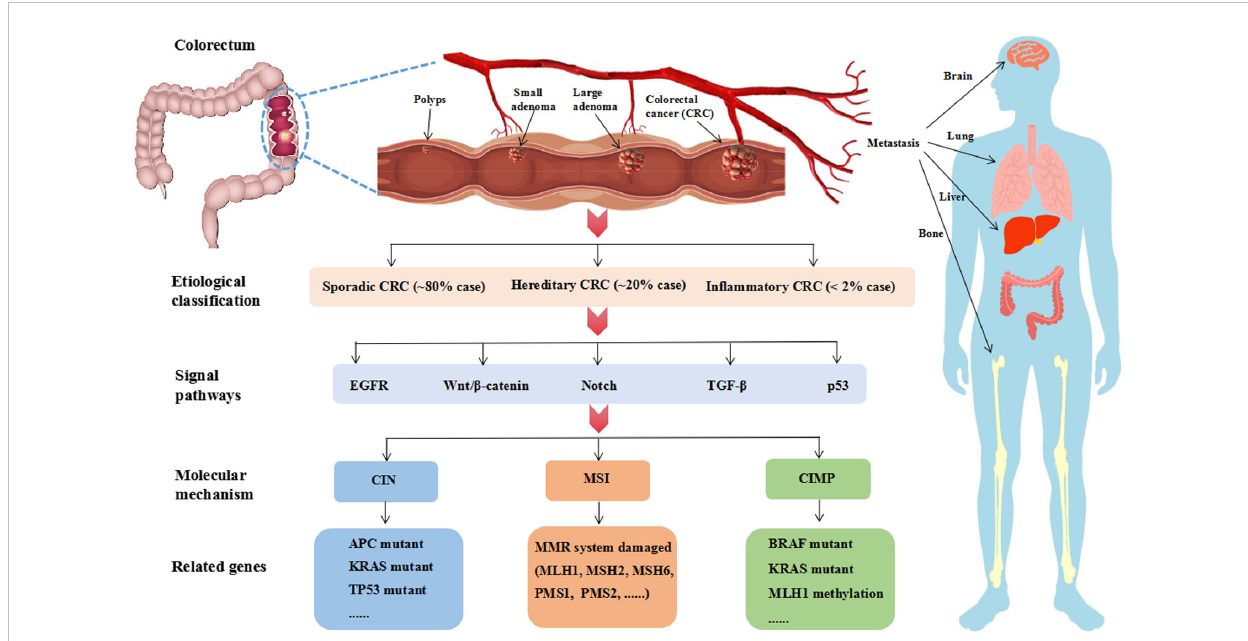
FIGURE 2 The pathological process, classi fi cation, signal pathway and molecular mechanism of CRC. The classic pathological process of CRC is “ polyps- adenoma-adenocarcinoma ” , which needs over 10 years. Advanced CRC is prone to metastasis. Liver metastasis is the most common CRC more than 50%. According to the etiology, CRC can be divided into three classi fi cations. Sporadic CRC is the most common clinical case accounting for approximately 80%. Hereditary CRC is associated with genetic factors accounting for approximately 20%, in which 2-5% cases are caused by inherited syndrome such as Lynch syndrome and familial adenomatous polyposis. In fl ammatory CRC is rare in clinical, which is less than 2%. As reports, EGFR, Wnt/ b -catenin, Notch, TGF- b and p53 are the main signal pathways at present. And CIN, MSI, CIMP are the major molecular mechanism. CIN is related to high gene mutant of APC, KRAS and TP53. MSI is driven by the impairment of DNA mismatch repair (MMR) system. CIMP is a form of epigenetic modi fi cation and relates to the hypermethylation of CpG islands. CIMP-high subtype is BRAF mutations and MLH1 methylation and CIMP-low subtype is KRAS